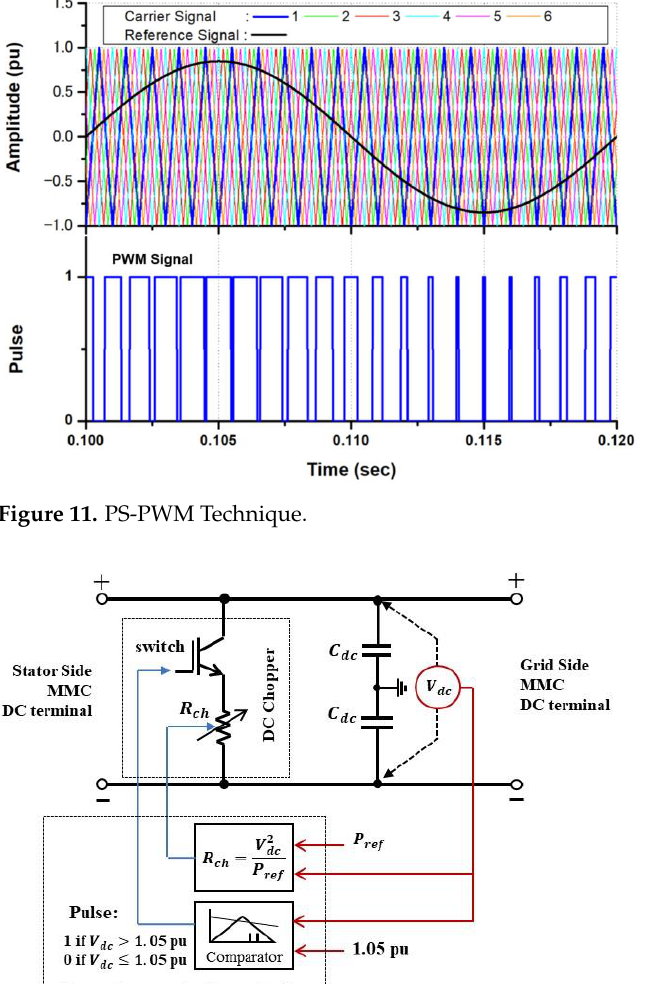
Figure 11. PS-PWM Technique.